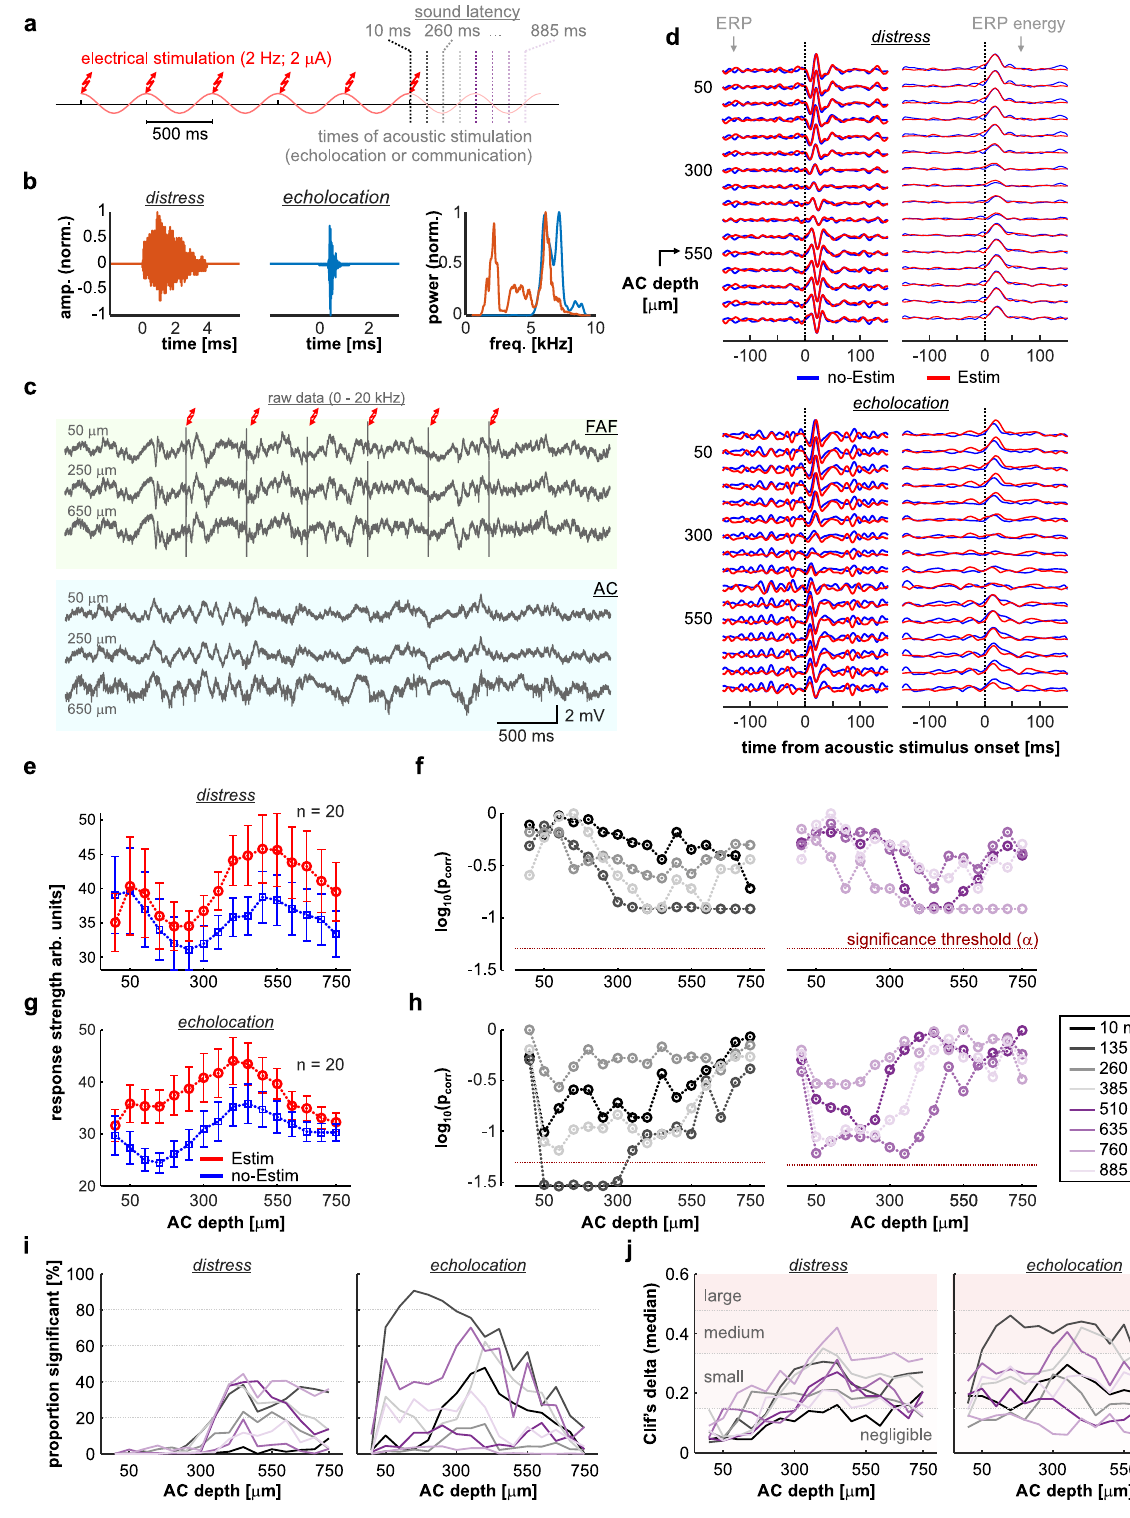
facilitates feedback processing 32 . Thus, pre-vocal, call-type unspeci fi c power changes in low frequencies could re fl ect gen- eral inhibitory mechanisms in AC consistent with corollary dis- charges from higher order structures. Directed connectivity analyses support the notion of top-down (FAF → AC) control of pre-vocal low-frequency activity (Fig. 2). In contrast, pre-vocal β -